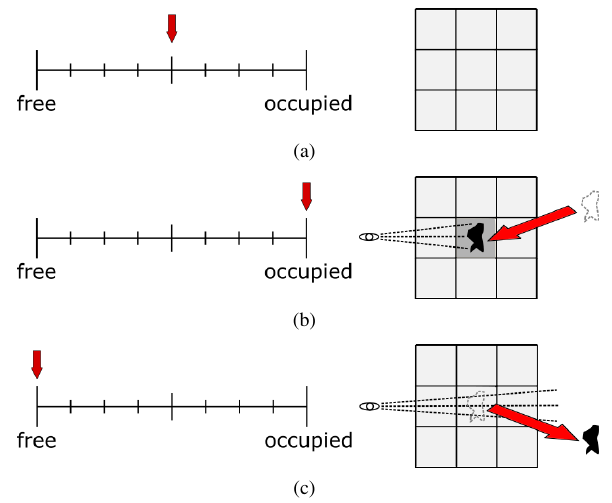
Figure 1. The influence of an object to a voxel’s log-odd based occupancy probability. (a) Voxel with zero knowledge. (b) Voxel occupied by an object. (c) Voxel after the object left.